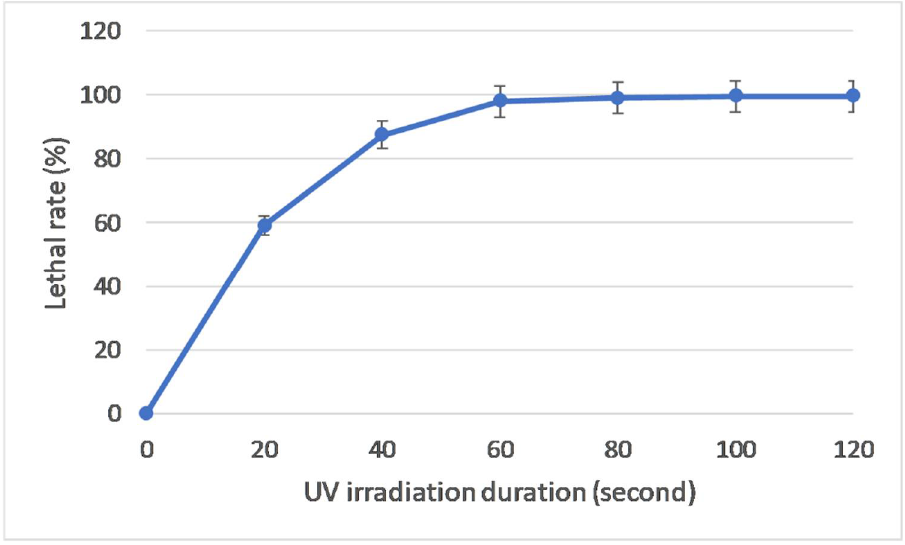
Figure 3. Lethality curve for UV irradiation duration.